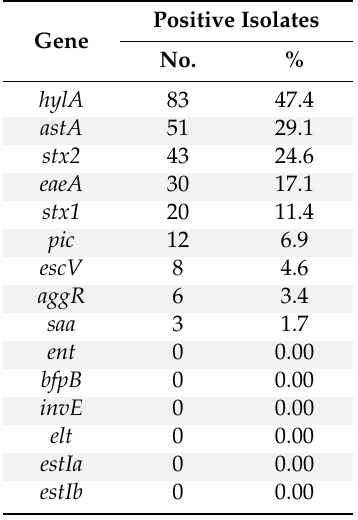
Table 1. Number and percentage of isolates positive to virulence genes. Positive Gene